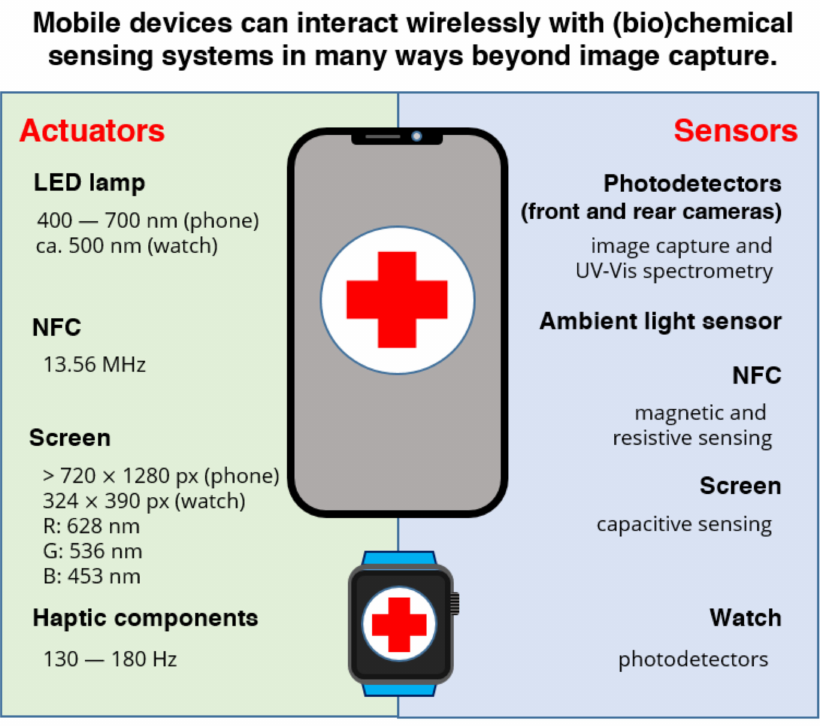
Figure 2. Summary of the main actuation and detection modes currently available in smart personal